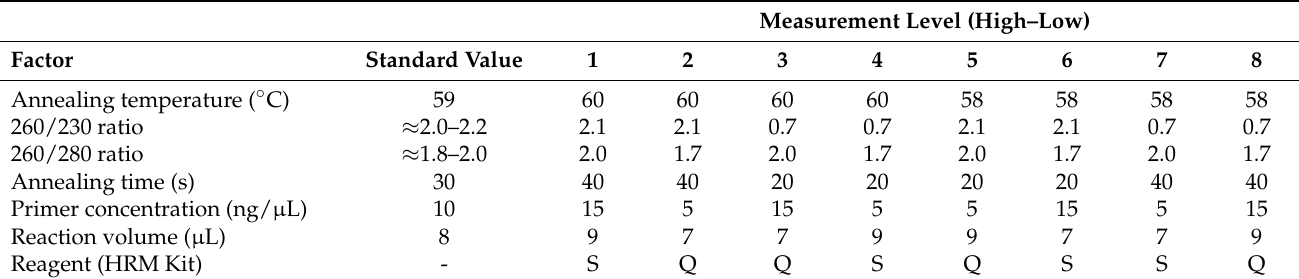
Table 2. Parameters used in eight trials for the robustness study